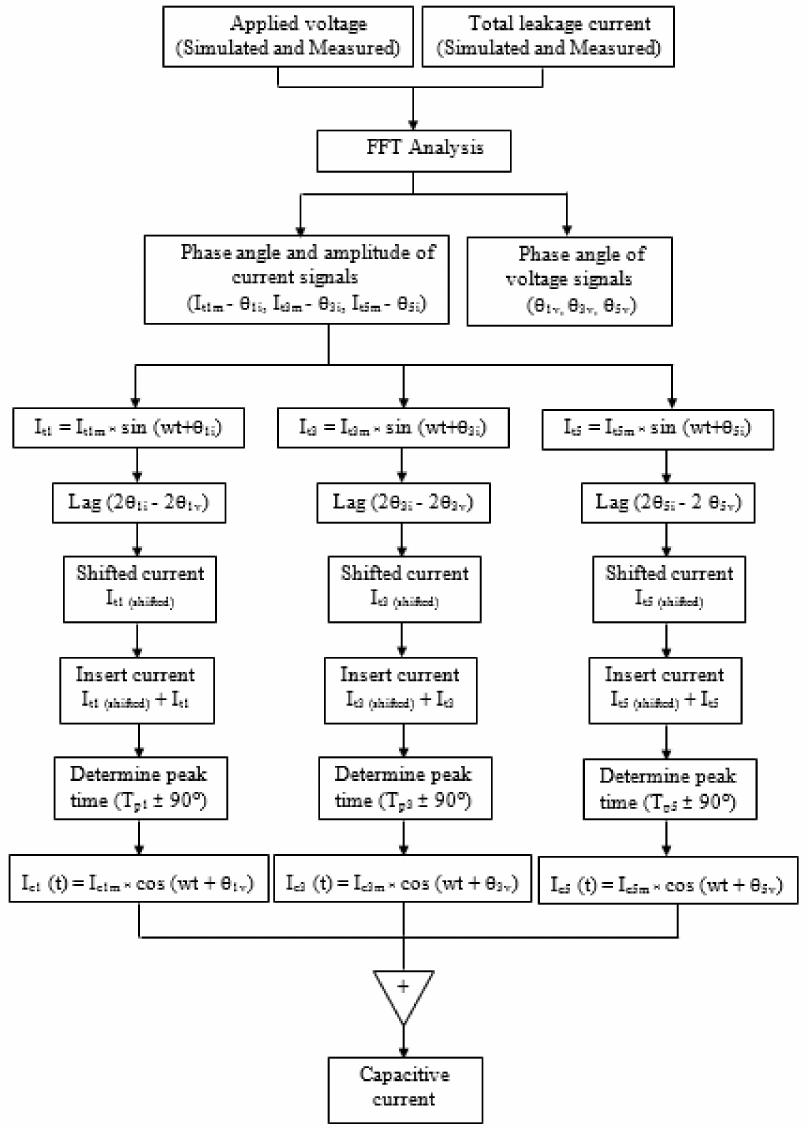
Figure 5. Block diagram of ITDAM